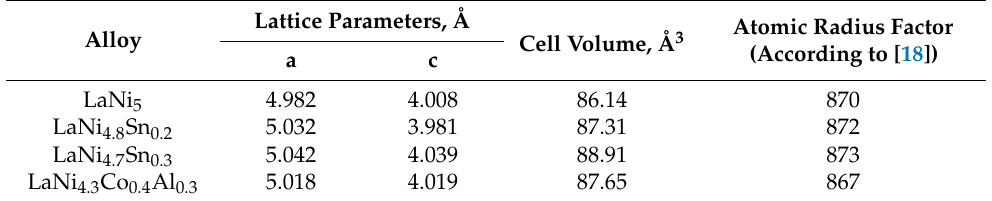
Table 1. Experimentally determined lattice parameters, the crystal cell volume and the Atomic Radius Factor for LaNi 5 based alloys.